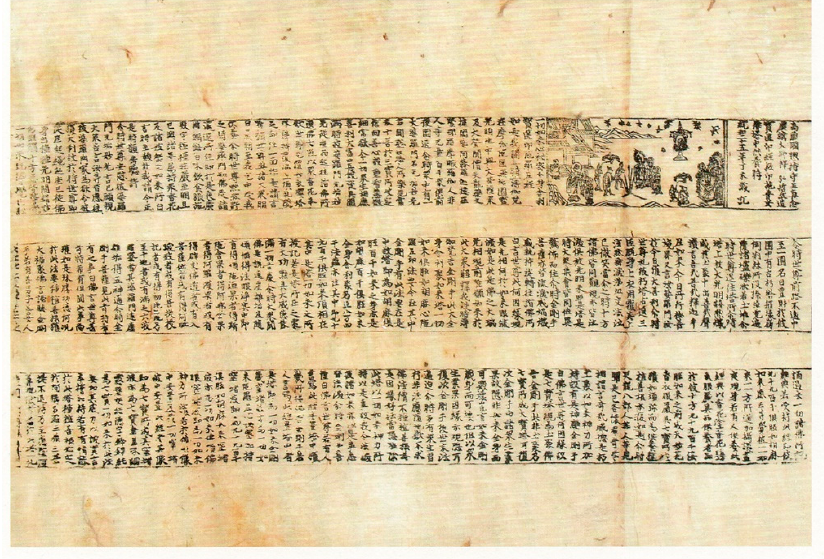
Figure 4. Casket Seal Dharani (K. Bohyeopin darani), Goryeo (1007), 32.3 × 45 cm, Enshrined in the statue Wooden Seated Avalokitesvara of Bogwangsa Temple. Source: (Central Buddhist Museum 2014, p. 99).